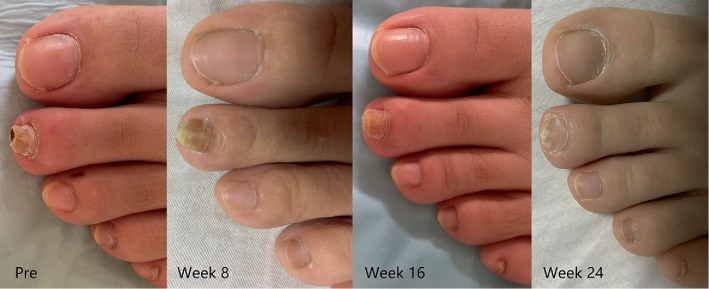
Images before and after 12 treatment sessions for toenail onychomycosis.